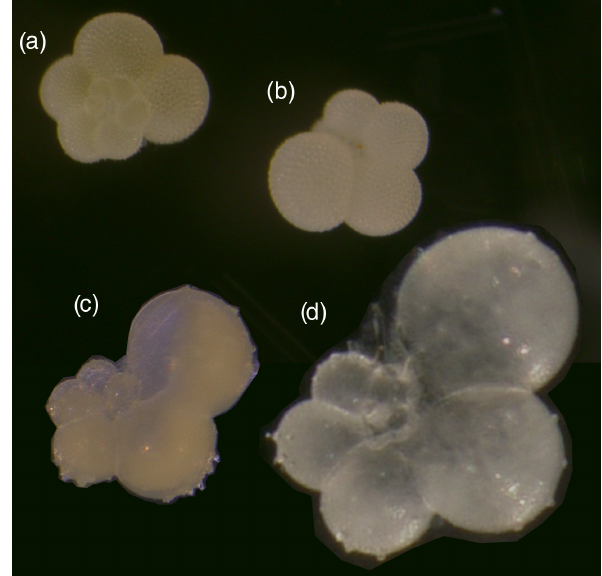
Figure 2. A side-by-side comparison from the same tow of (a) a dorsal view of a live (cytoplasm containing) G. hexagonus and (b) a ventral view of the empty test of G. hexagonus , as well as (c) a live and (d) empty H. parapelagica